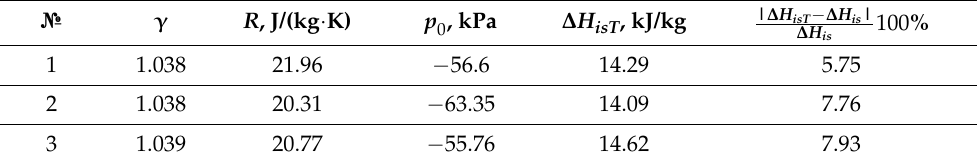
Table 5. Constants of the Tammann equation of state and the resultant isentropic enthalpy drop. №